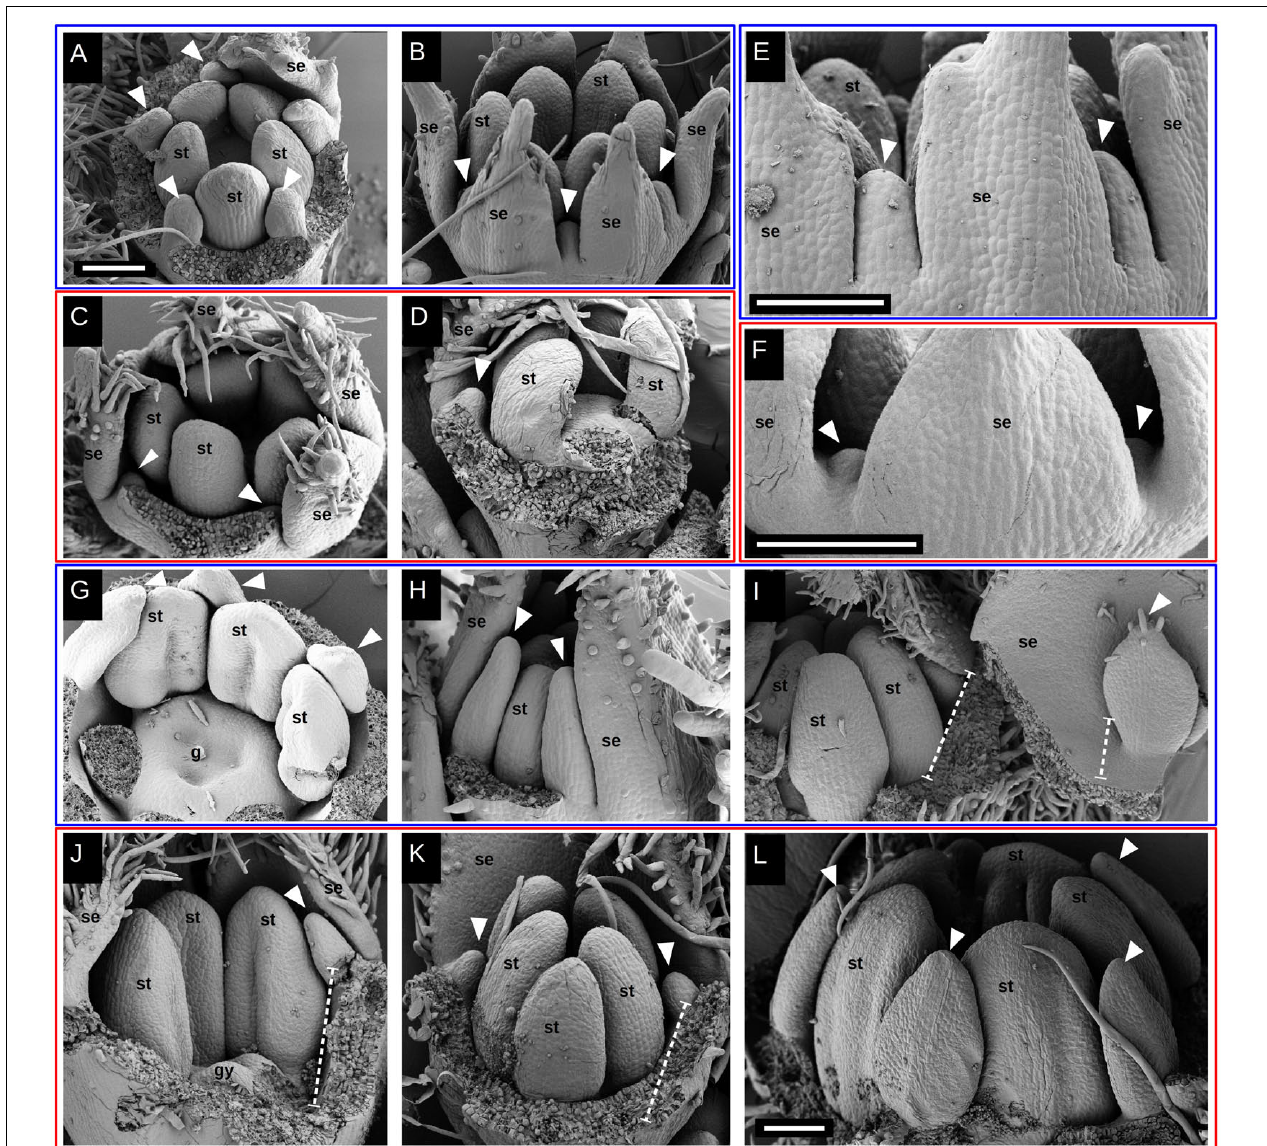
FIGURE 4 | Petal elongation during flower development in Malesherbia . Tubular (blue frame) and Radiate (red frame) species at similar stages for comparison: (A) and (B) v/s (C) and (D) ; (E) v/s (F) ; (G,H) and (I) v/s (J,K) and (L) . (A) Tubular M. corallina showing petals (arrowheads) elongating and alternating with stamens (st). Sepal lobes removed. (B) Tubular M. auristipulata at a comparable stage showing erect growing young petals. (C) M. lanceolata showing similar stamen (st) primordium size as in Tubular species (A) and (B) , but with markedly smaller petal primordia shown by arrowheads. (D) M. densiflora at similar stage regarding stamen primordium size and also showing a small protruding petal primordium (arrowhead). (E) View of perianth of Tubular M. auristipulata showing alternating sepal (se) and petal (arrowheads) lobes all inserted on the external perimeter. (F) Comparable view of Radiate M. obtusa showing much more retarded petal primordia situated more internally than in panel (E) . (G) M. auristipulata ; young flower showing stamen (st) with thecal ridge differentiation and well-formed petals outgrowing stamens (arrowheads). A trilocular gynoecium (g) covers the center of the flower. Sepals removed. (H) Tubular M. tocopillana at a similar stage as G and equivalent large young petals (arrowheads) outgrowing stamens (st). Sepals (se) enclose flower bud, therefore one sepal is removed. (I) M. tenuifolia showing ventral face of petal (arrowhead) and sepal (se) plus a fraction of the hypanthium (dashed line). This part of the perianth has been torn open from the flower bud that shows young stamens (st). Note the growing trichomes on the petal tip indicating tissue maturation. (J) Radiate M. lanceolata young flower showing gynoecium and stamen differentiation at a similar stage as (G–I) . Note the markedly smaller petal primordium (arrowhead) than in previous species. (K) M. densiflora at a similar stage as (J) , also showing quite retarded and small petal primordia. (L) M. densiflora showing petals (arrowheads) differentiated to a similar extent as shown for Tubular species in panels (G–I) , but with a much larger overall size. Note that even at this size, the petals still do not overgrow the stamens. All bars = 100 µ m. fm = flower meristem, se = sepal, st = stamen, gy = gynoecium, white arrowhead = petal primordium, dashed line: hypanthium outline.